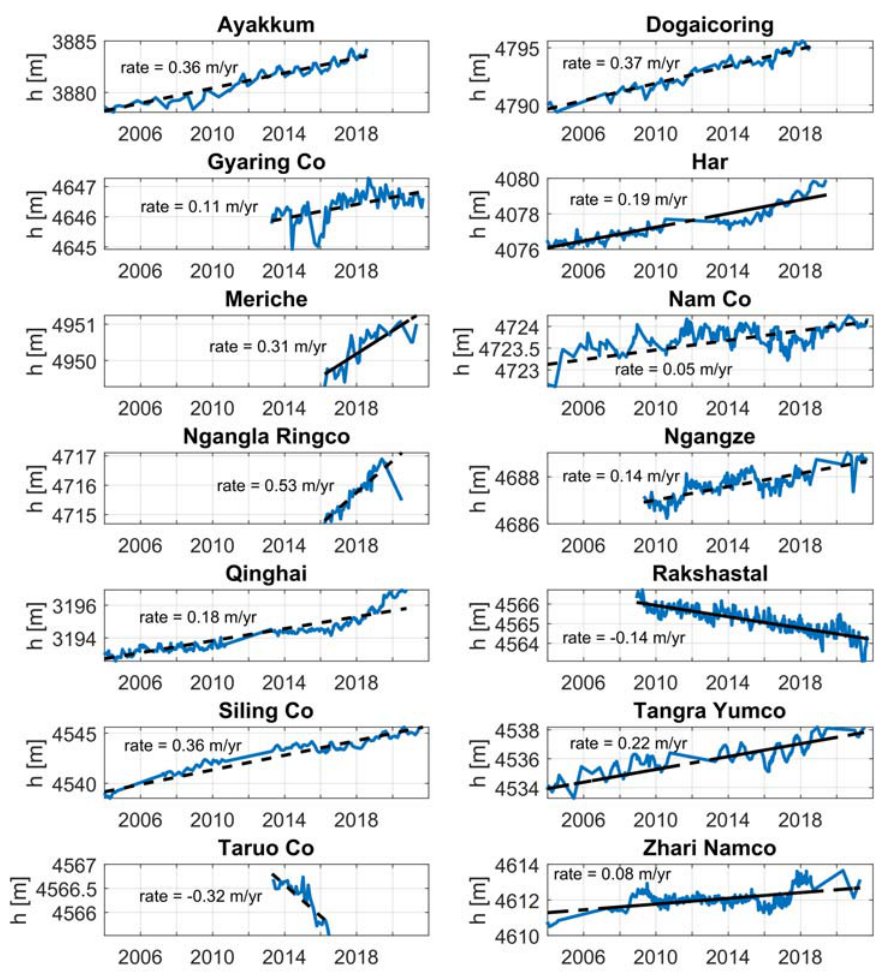
Figure 4. Temporal variations of lake levels in Tibet area (cyan) for the DAHITI catalogue; extrapo- lated rates in black.